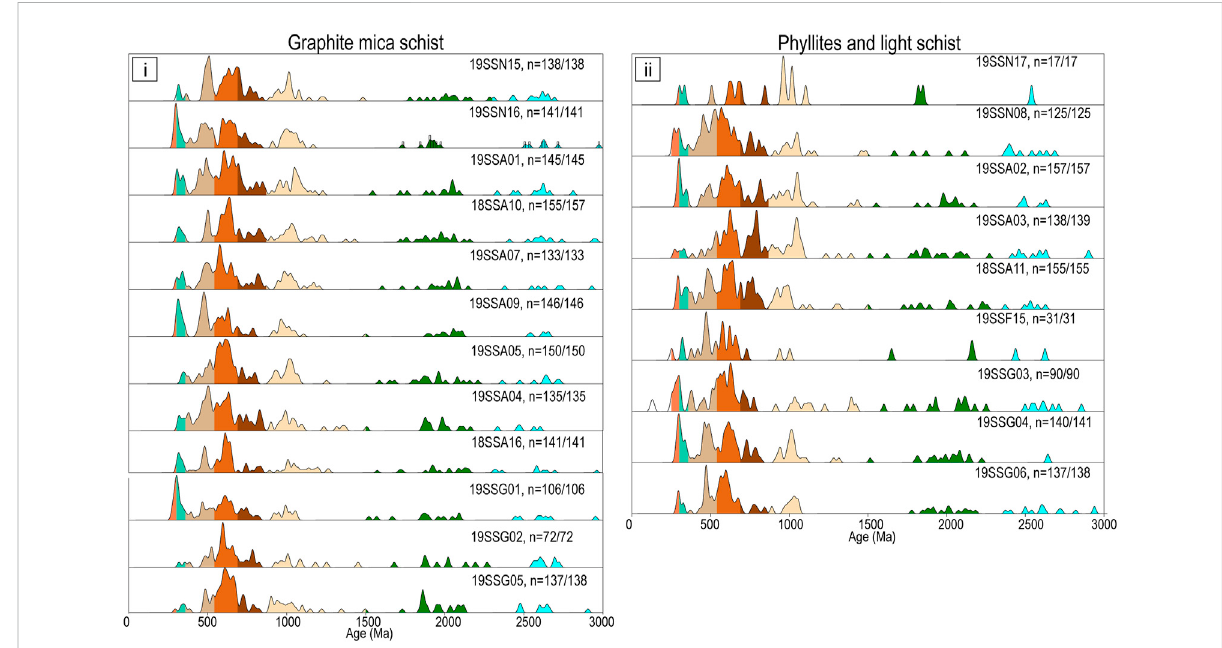
FIGURE 4 Kernel density estimate plots showing the detrital zircon spectrum of individual samples from the Alpujárride Complex organized by lithology; (A) graphitemicaschistand (B) Phyllitesandlightschist.Colorshighlightthedifferentagemodes(lightblue:Jurassic,pink:Triassic,orange:Permian, light green: Carboniferous, light brown: Early Paleozoic, burnt orange: Ediacaran, dark brown: Early Neoproterozoic, beige: Mesoproterozoic (1,000 – 1,600 Ma), green: Paleoproterozoic, and cyan: Archean). N = #/# shows the number of zircon grains appeared on the KDE space vs. analyzed and passed the discordance fi